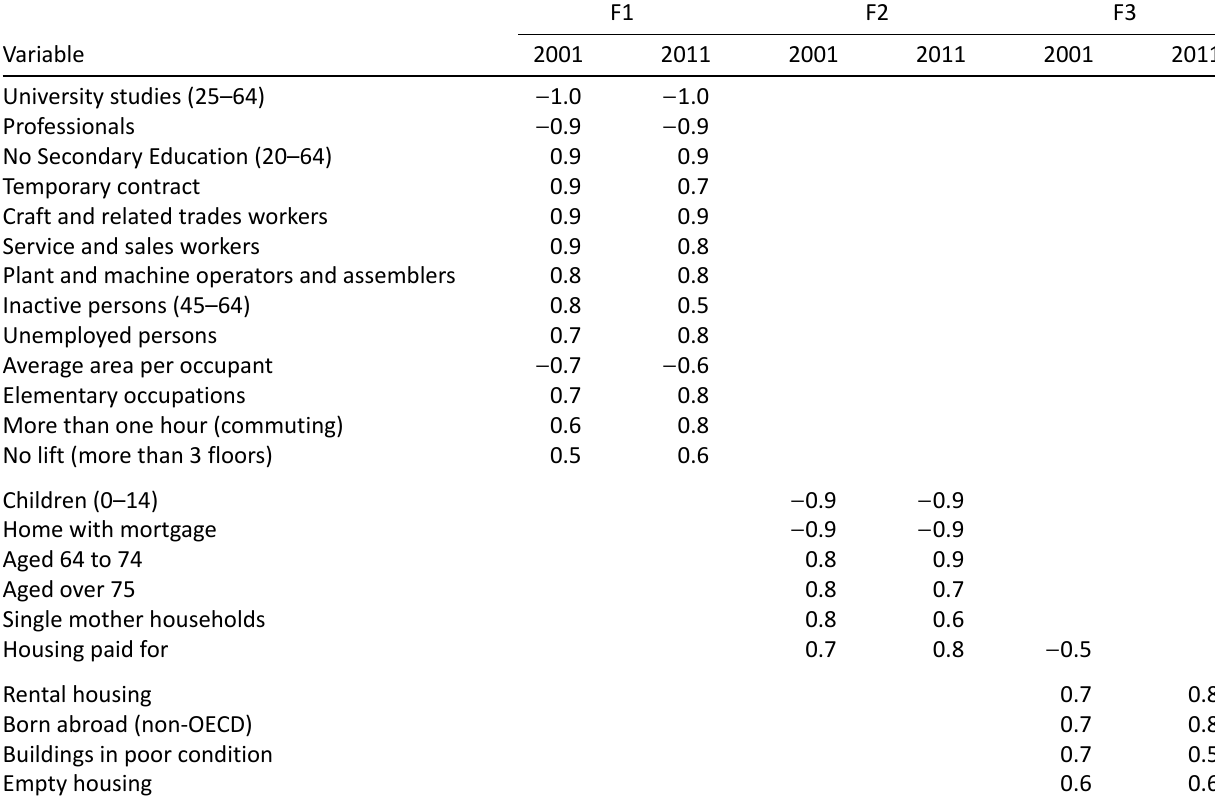
Table 1. Composition of social residential differentiation factors in 2001 and